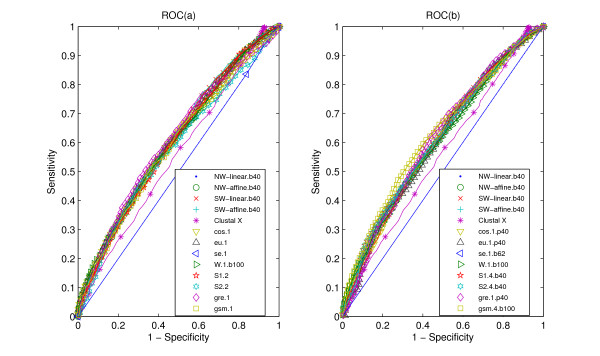
ROC curves for data RS. ROC (a) for our measures, alignment-based measures and other statistical measures, all the statistical measures are based on k-word frequencies of protein sequence, with the parameter values as suffix. ROC (b) for our measures, alignment-based measures and other statistical measures, all the statistical measures are based on k-word frequencies of protein 'sequence space', with the parameter values as suffix. All the abbreviations of (dis)similarity measures are illustrated in the "List of abbreviations" section. A random classifier would generate equal proportions of FP and TP classifications, which corresponds to the ROC diagonal (dashed line).